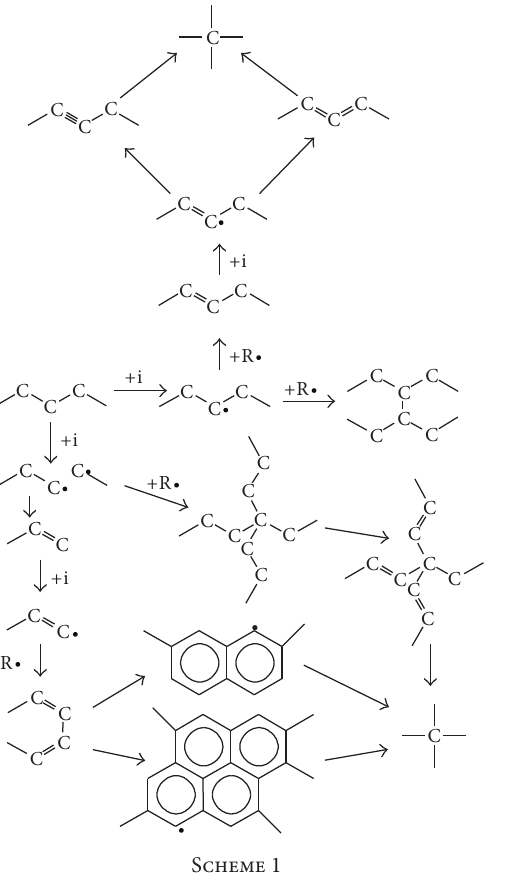
(Figure 12). e contributions of the polar and dispersive parts of the total surface energy are different. e polar part of the surface energy increases signi�cantly